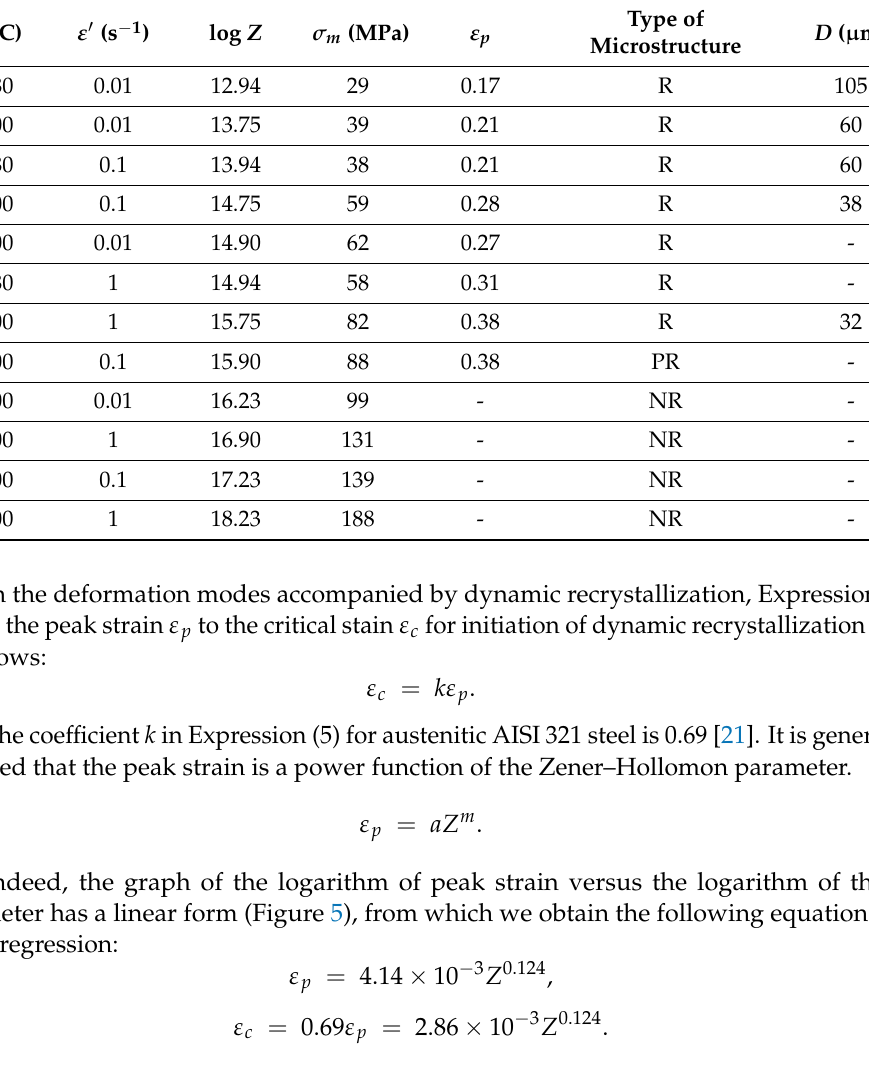
Table 2. Deformation modes and their corresponding